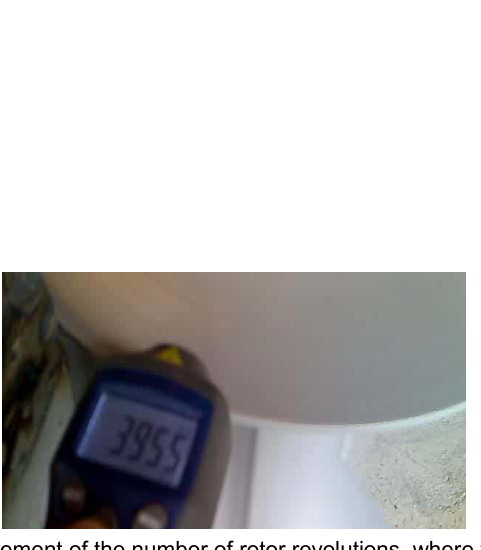
Figure 9 – Measurement of the number of rotor revolutions, where the vertical angle of the wind inlet is, in this case, increased for 15° Рис . 9 – Измерение количества оборотов вращения ротора , при увеличении